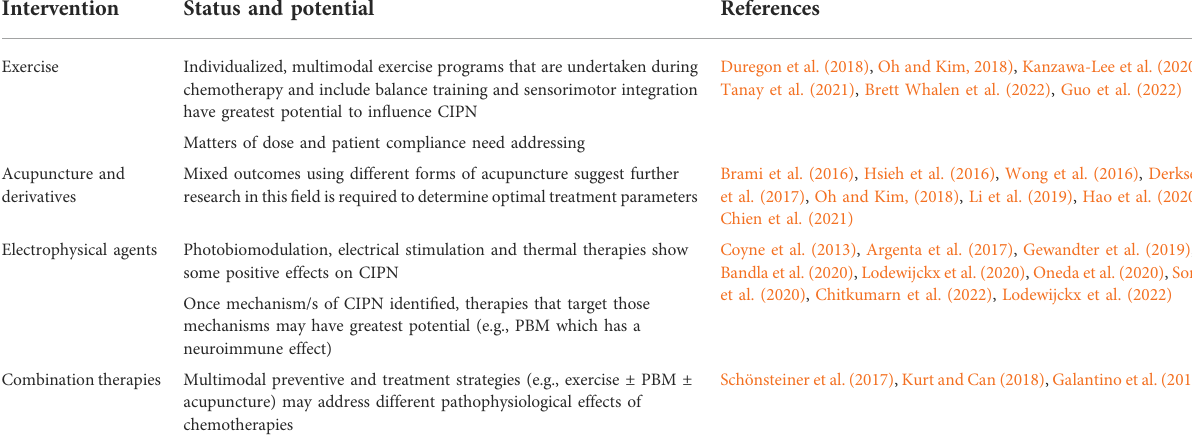
TABLE 6 Status of types of non-pharmacological methods to prevent, treat or limit severity of CIPN. Intervention Status and